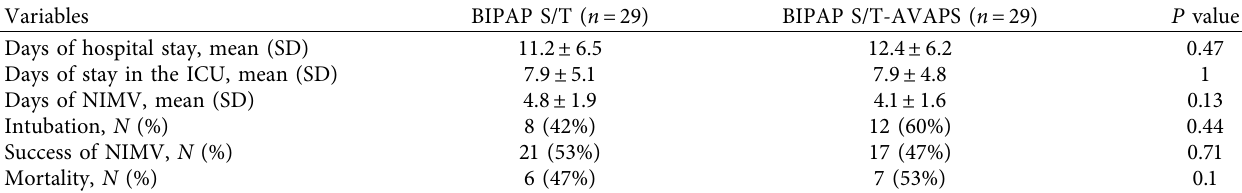
Table 3: Comparative outcome in the BiPAP S/T and BiPAP S/ T +AVAPS